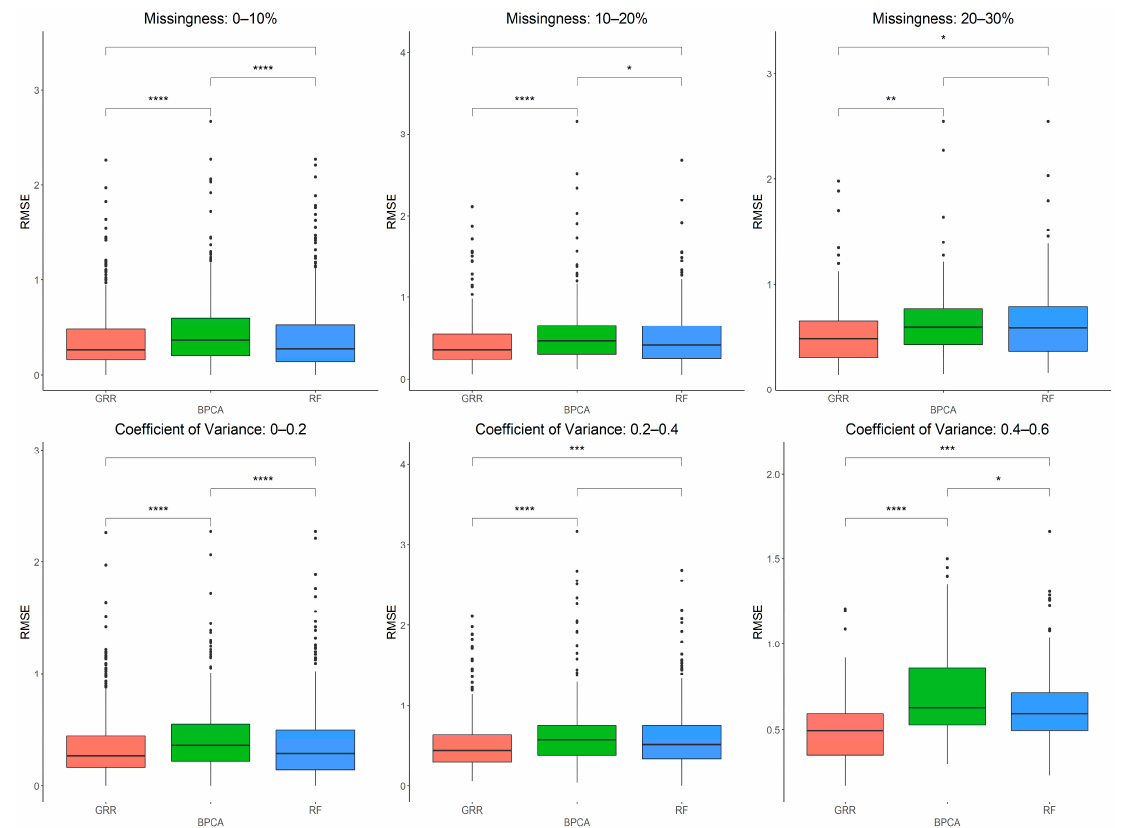
Figure 3. Evaluations of imputation accuracy in the complete baboon plasma. Accuracy is evaluated for levels of missingness types (MCAR–MAR–MNAR). Methods are listed across the x-axis, and RMSE is shown on the y-axis. The top row compares accuracy across a range of missingness types. The bottom row compares accuracy across a range of coefficients of variance. The center line represents the median. The lower and upper box limits represent the 25% and 75% quantiles, respectively. The whiskers extend to the largest observation within the box limit ± 1.5 × interquartile range. Black dots represent single iterations of evaluating RMSE that are outliers. The p -values are based on pairwise testing with the Wilcoxon Rank Sum test (* corresponds to p ≤ 0.05; ** corresponds to p ≤ 0.01; *** corresponds to p ≤ 0.001; **** corresponds to p ≤ 0.0001).